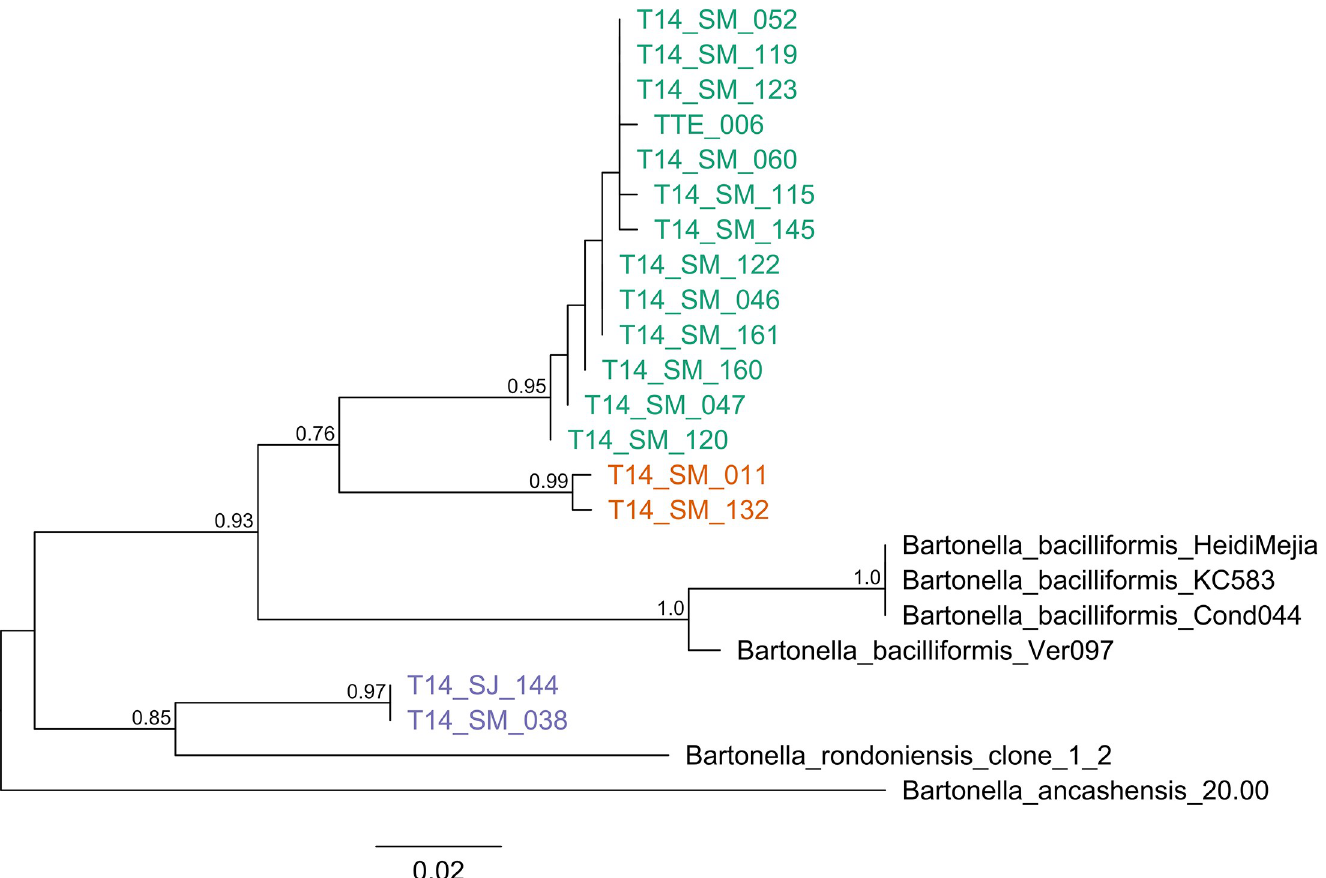
Fig 6. Maximum likelihood tree for Bartonella species in Lutzomyia spp. based on gltA gene sequences. The three lineages are in colors, lineage 1 in green, lineage 2 in orange, and lineage 3 in purple. Lineages 1 and 2 are related to B . bacilliformis , and lineage 3 is related to Candidatus B. rondoniensis. TTE-006 = Lu . whitmani from Iberia, Madre de Dios; T14-SM-011 and T14-SM-132 = Lu . hirsuta hirsuta from San Martin; T14-SM-052 = Lu . sherlocki from San Martin; T14-SM-038, T14-SM-046, T14-SM-047, T14-SM-060, T14-SM-115, T14-SM-119, T14-SM-120, T14-SM-122, T14-SM-123, T14-SM-145, T14-SM-160, T14-SM-161 = Lu . nevesi from San Martin; and T14-SJ-144 = Lu . maranonensis from Cajamarca. The numbers on the branches represent bootstrap support and the size bar indicates 0.02 substitutions per